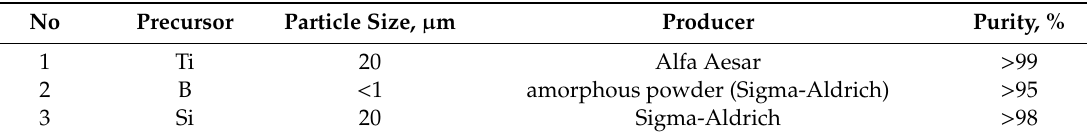
Table 1. Precursor